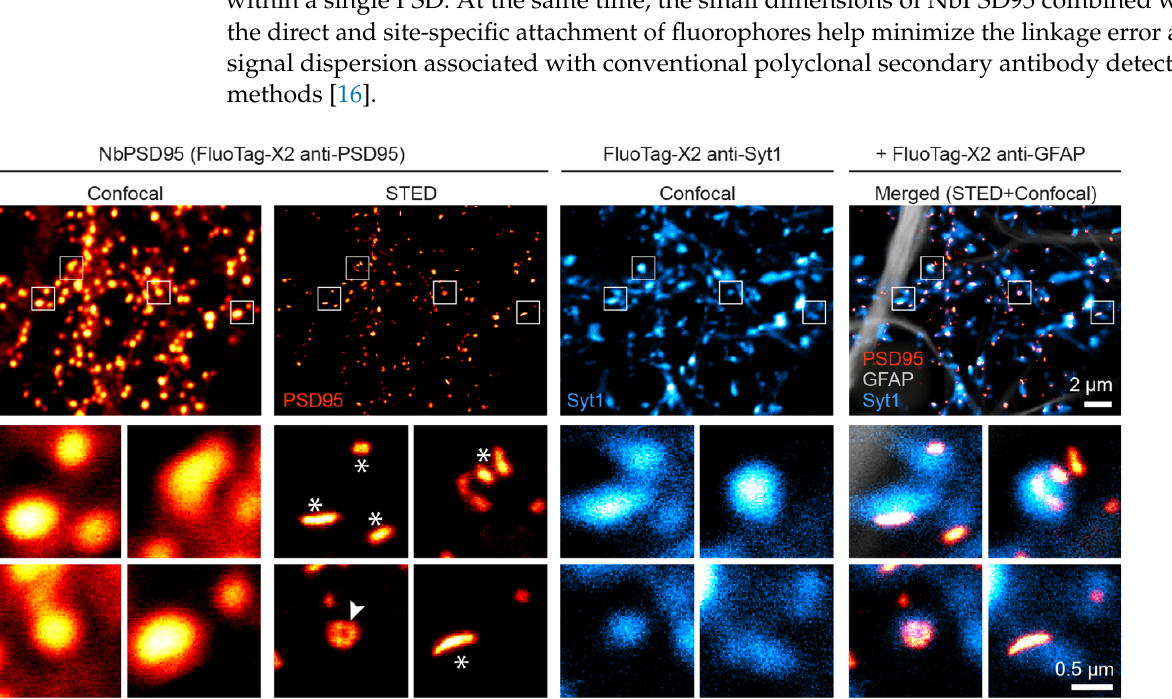
Figure 4. Confocal and STED imaging on primary rat hippocampal neurons. Primary hippocampal culture neurons were stained using NbPSD95 (FluoTag-X2 anti-PSD95, red) conjugated to Abberi- orStar635P and imaged using Confocal and STED microscopy. For counterstaining, the pre-synaptic protein Synaptotagmin 1 (Syt1; cyan) and glia marker GFAP (grey) were imaged in confocal mode for reference. Four selected regions denoted by white squares are magnified, displaying conventional lateral PSD shapes (asterisks) as well as so-called perforated synapses (arrowheads) only visible under STED microscopy.